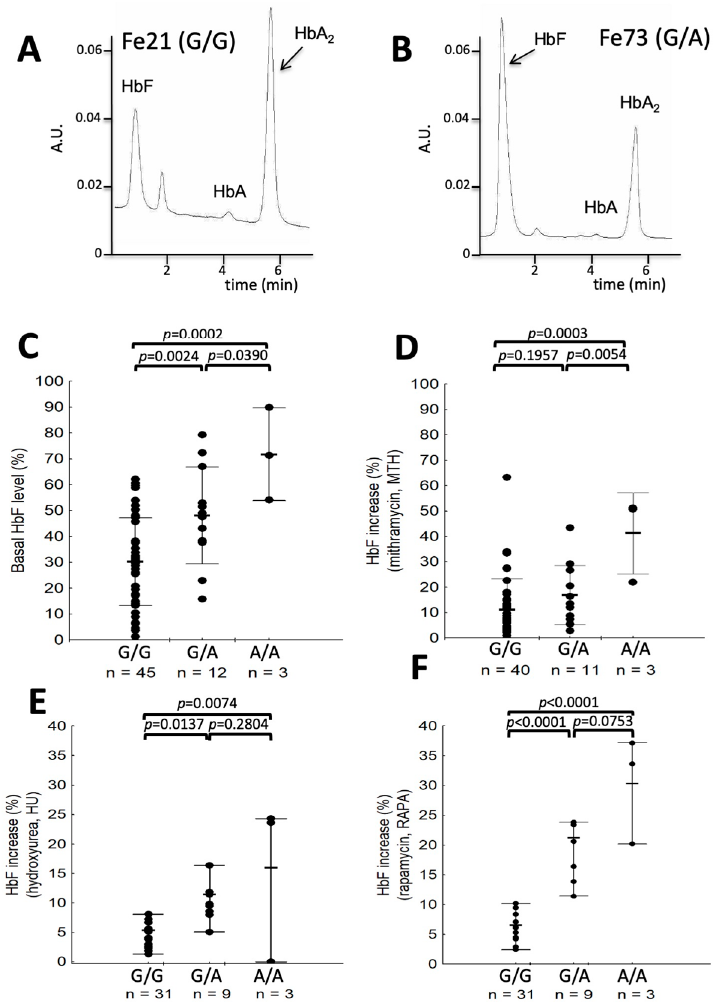
Figure 2. ( A , B ). Representative HPLC profile of ErPC lysates from β -thalassemia patients producing low ( A ) and high ( B ) HbF levels. ( C ) Basal levels of HbF in a total of 60 β -thalassemia patients. ( D – F ) HbF induction in ErPCs from G/G, G/A, and A/A β -thalassemia patients treated for 5 days in the presence of 30 nM mithramycin ( D ), 100 µ M hydroxyurea ( E ), and 250 nM rapamycin ( F ). The percent of HbF increase was determined as described in the legend in Figure 1. ANOVA was used to test differences in the percent of HbF increase among genotypes; a post hoc LSD test was used, and the p values are indicated in each panel. “n” identifies the number of different patients recruited. When more than one induction experiment was performed, each dot represents the average of the percent HbF increase. The Shapiro–Wilk test was applied to analyze the data distribution of all quantitative traits. Logarithmic transformation was necessary either for baseline HbF levels ( C ) or for increased HbF levels after treatment with the three inducers ( D – F ). To test differences in the percent of HbF increase among genotypes, ANOVA was used on transformed data ( D – F ). A post hoc LSD test was used, and the p values are indicated in each panel in Figure 2. Averages and standard deviations of original data are shown for a straight